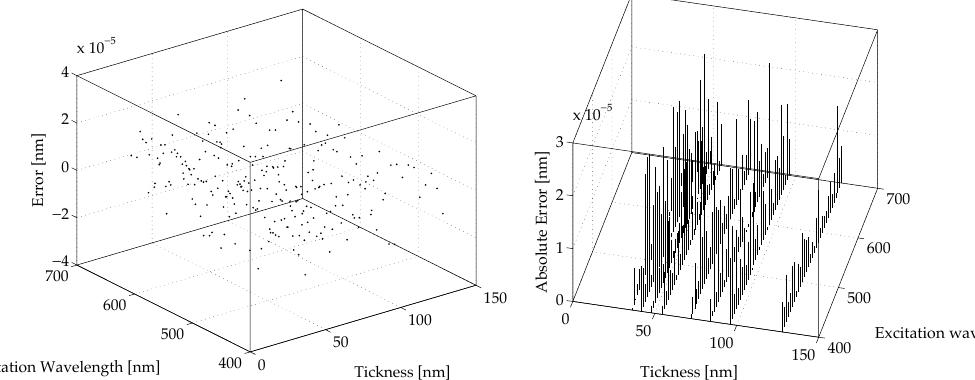
Figure 7. The obtained results: the model error E L Equation (11). The ( left ) shows the prediction error for L SPP and the ( right ) shows its absolute